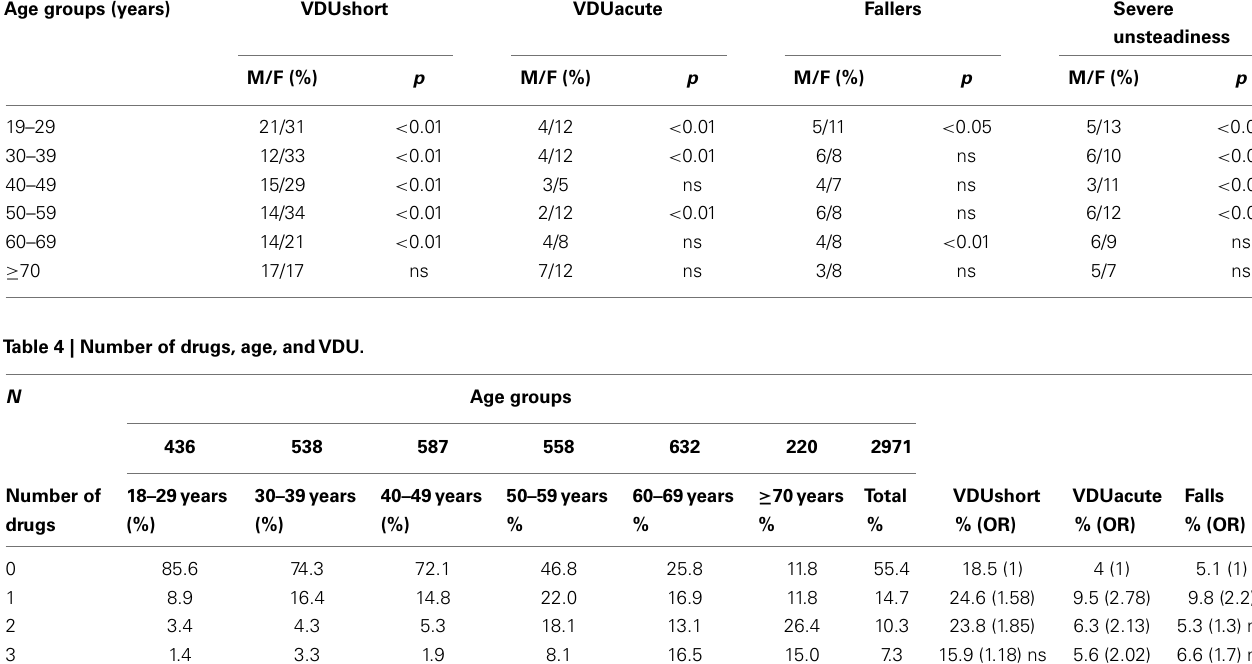
Table 3 | Percentages per age group and gender comparison forVDUshort,VDUacute, falls, and severe unsteadiness. Age groups (years)